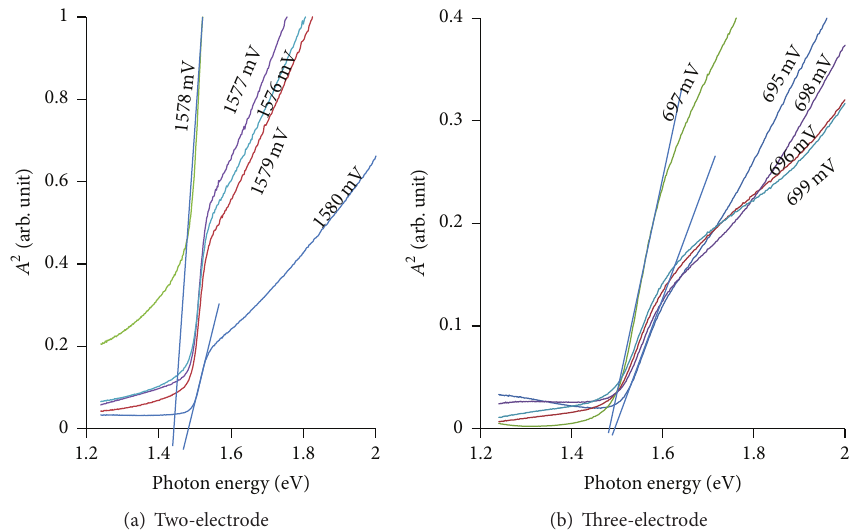
Figure 5: Square of absorbance ( 𝐴 2 ) versus photon energy of annealed CdTe samples grown with (a) two-electrode system and (b) three- electrode system at different cathodic voltages for 1